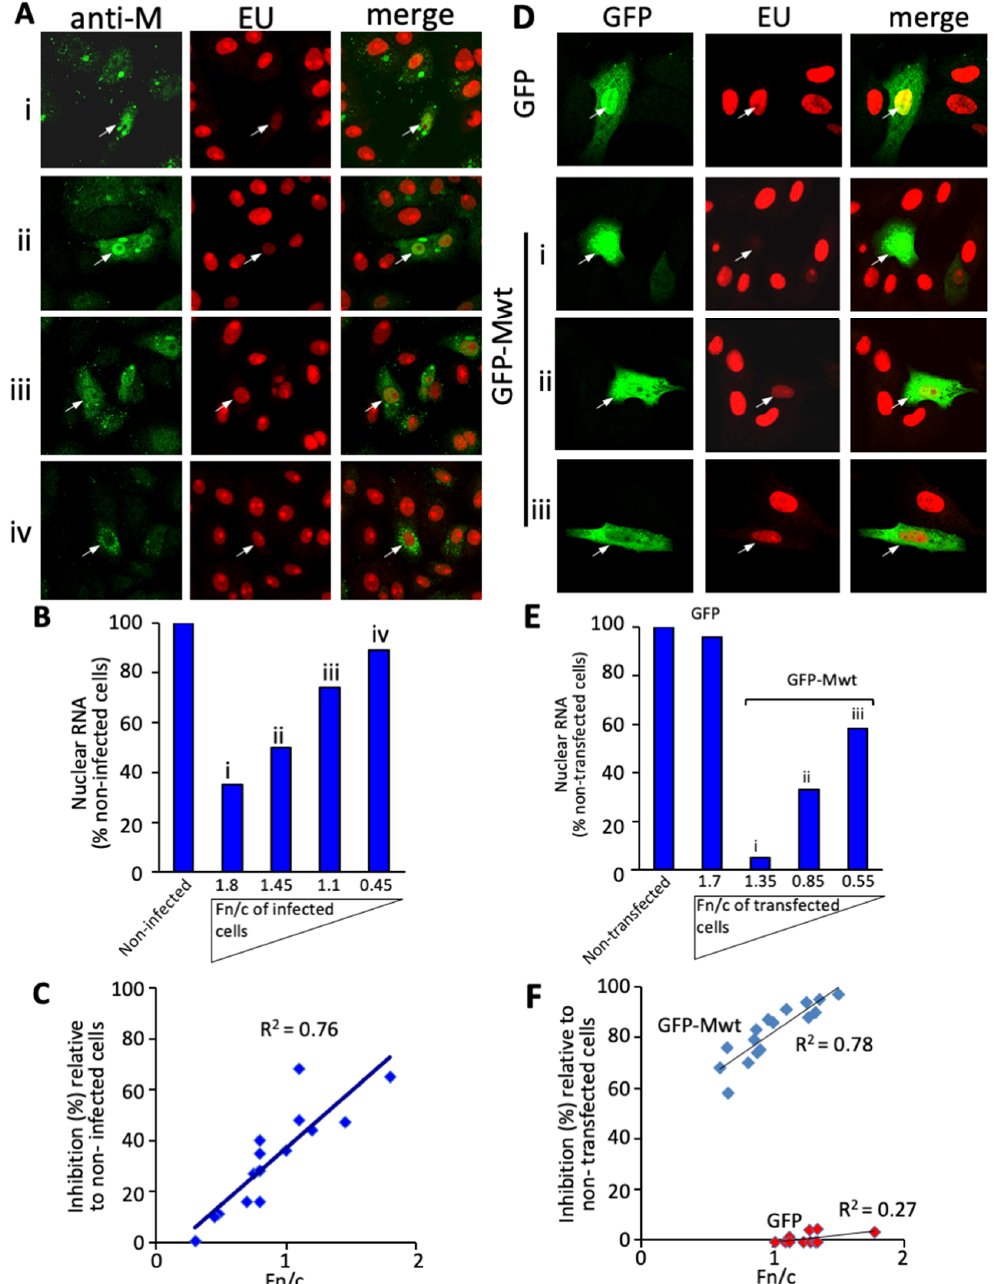
Figure 1. Inhibition of host transcription in RSV-infected cells is dependent on the extent of nuclear accumulation of RSV M. ( A ) Vero cells were infected with RSV at MOI of 3. At 24 h post-infection (p.i.), cells were incubated with 1 mM EU (see Methods) for 1 h, and then fixed, permeabilized, and specifically stained for de novo synthesized RNA using Alexa 594-azide, as well as for M using a specific monoclonal antibody followed by an Alexa 488-coupled secondary antibody. Representative CLSM images of subcellular localisation of M and de novo RNA synthesis in RSV infected cells derived using a 100X oil immersion objective (see 2.4) are shown. Merged images of the green (M protein) and red (EU incorporation reflecting de novo RNA synthesis) channels are shown; rows i-iv show cells, denoted by the arrows, with differing levels of intranuclear M, for which quantitative analysis is shown in ( B ). ( B ) Quantitation of the levels of M accumulation in the nucleus and EU incorporation from ( A ) by image analysis of the CLSM files in panel ( A ) using the NIH ImageJ software to determine the extent of nuclear accumulation of M (expressed in terms of the nuclear to cytoplasmic ratio, Fn/c) and levels of de novo synthesized RNA in infected cells (i–iv, indicated by arrows in ( A ), expressed as a percent of mock-infected cells in the same CLSM image in ( A ). ( C ) Linear regression ( n = 15; correlation coefficient indicated) for the results for single cell analysis as per ( B ) for a series of images as per A (including all of the cells in A i–iv) for the relative amount of